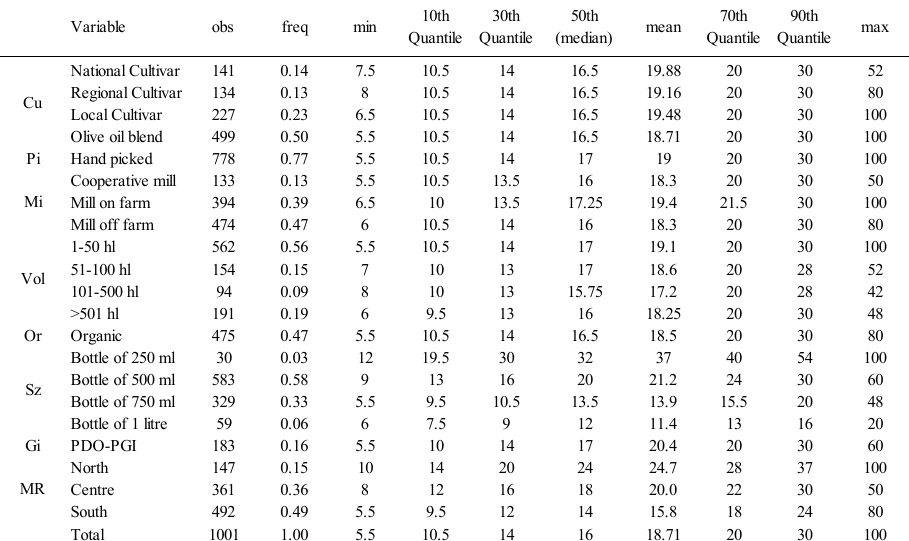
Table 1. Frequencies and descriptive statistics of price distribution for the different quality clues.